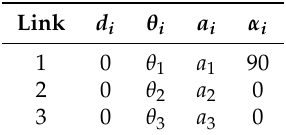
Table 1. DH parameter for robot